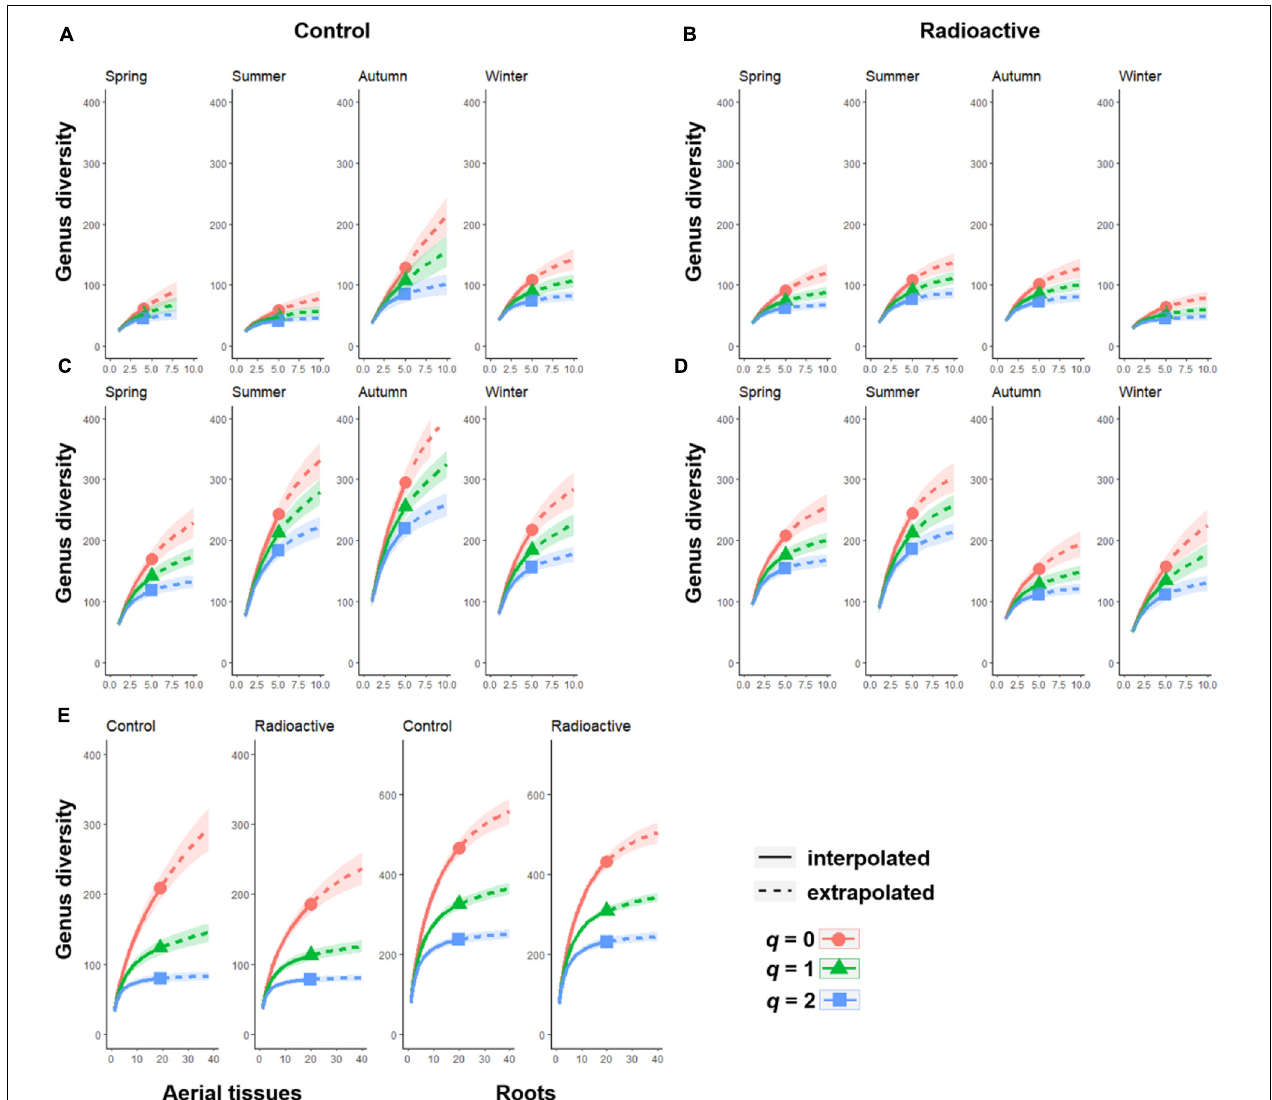
FIGURE 3 | The Hill numbers of order q indicate the diversity of endophytic bacteria in each season at the control or radiation stressed sites. The sample size based on rarefactions and extrapolations of four seasons are shown for the bacterial community in aerial tissues (A) or in roots (C) at the control site, and aerial tissues (B) or roots (D) at radiation stressed site. The overall rarefactions and extrapolations of different tissues across four seasons are also illustrated (E)